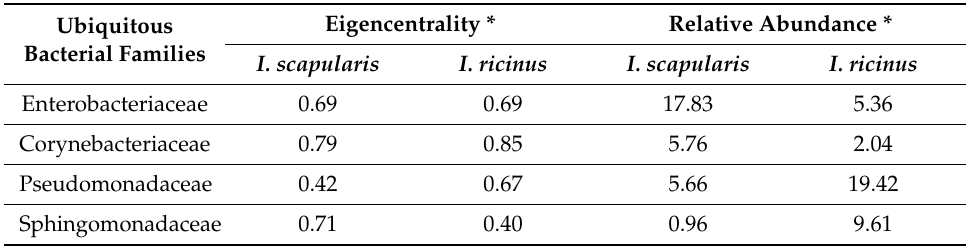
Table 1. Eigencentrality and relative abundance values of ubiquitous bacterial families in Ixodes spp.